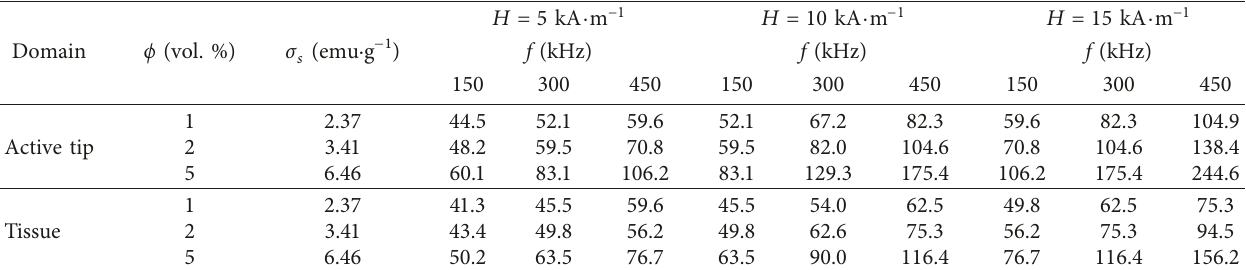
1 , and f 300 kHz. 15 mins, ϕ 5%, H 10 kA m (cid:31) (cid:31) (cid:31) (cid:31) · − 1 ) and frequencies (150–450kHz). m · −